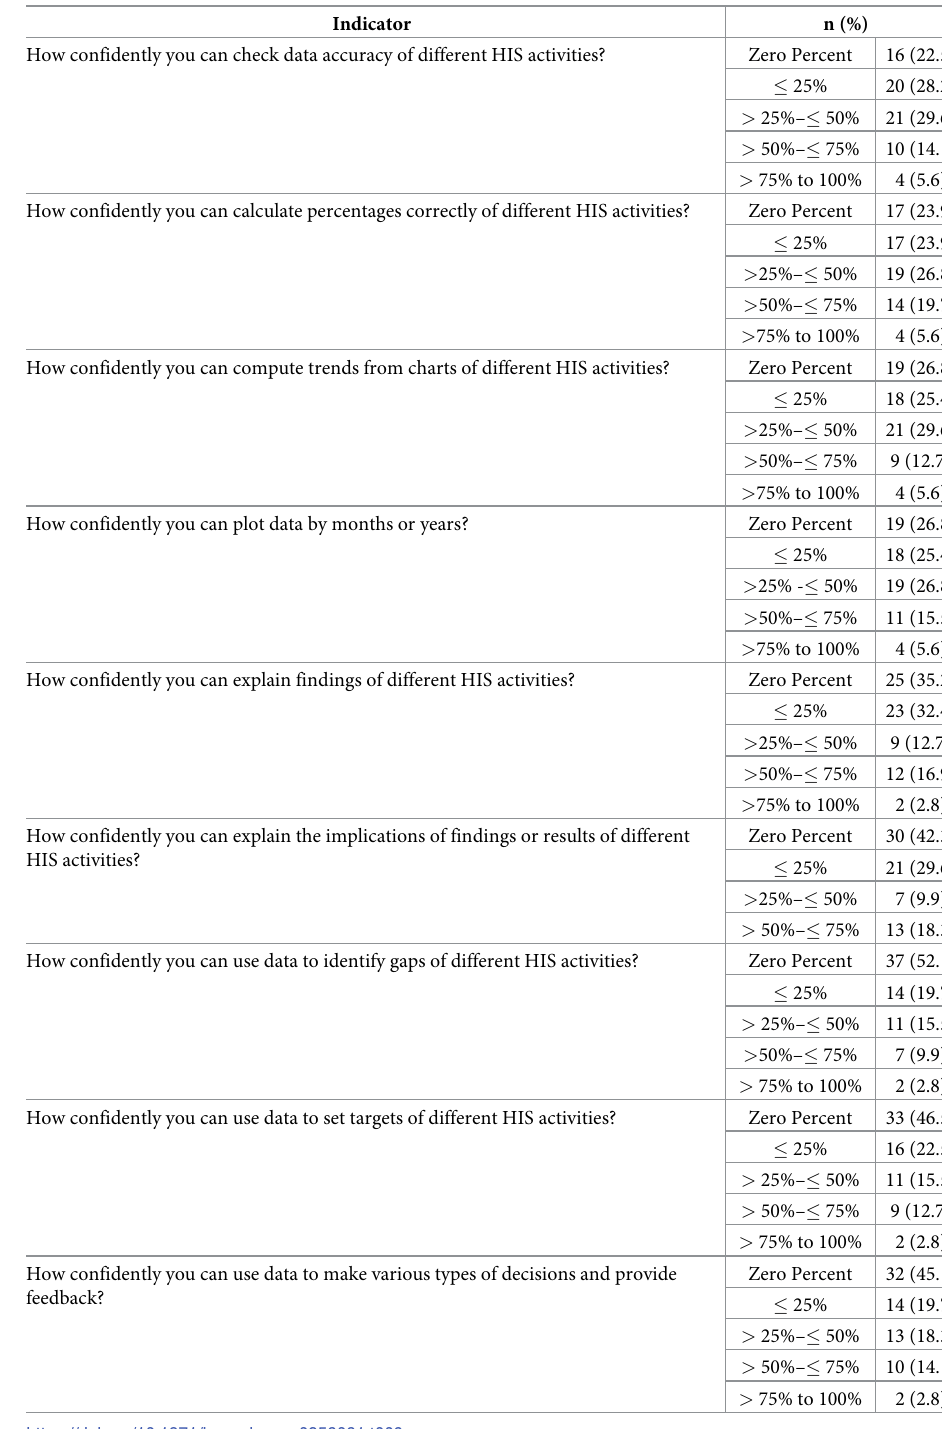
Table 9. Self-efficacy for performing tasks related to health information systems.